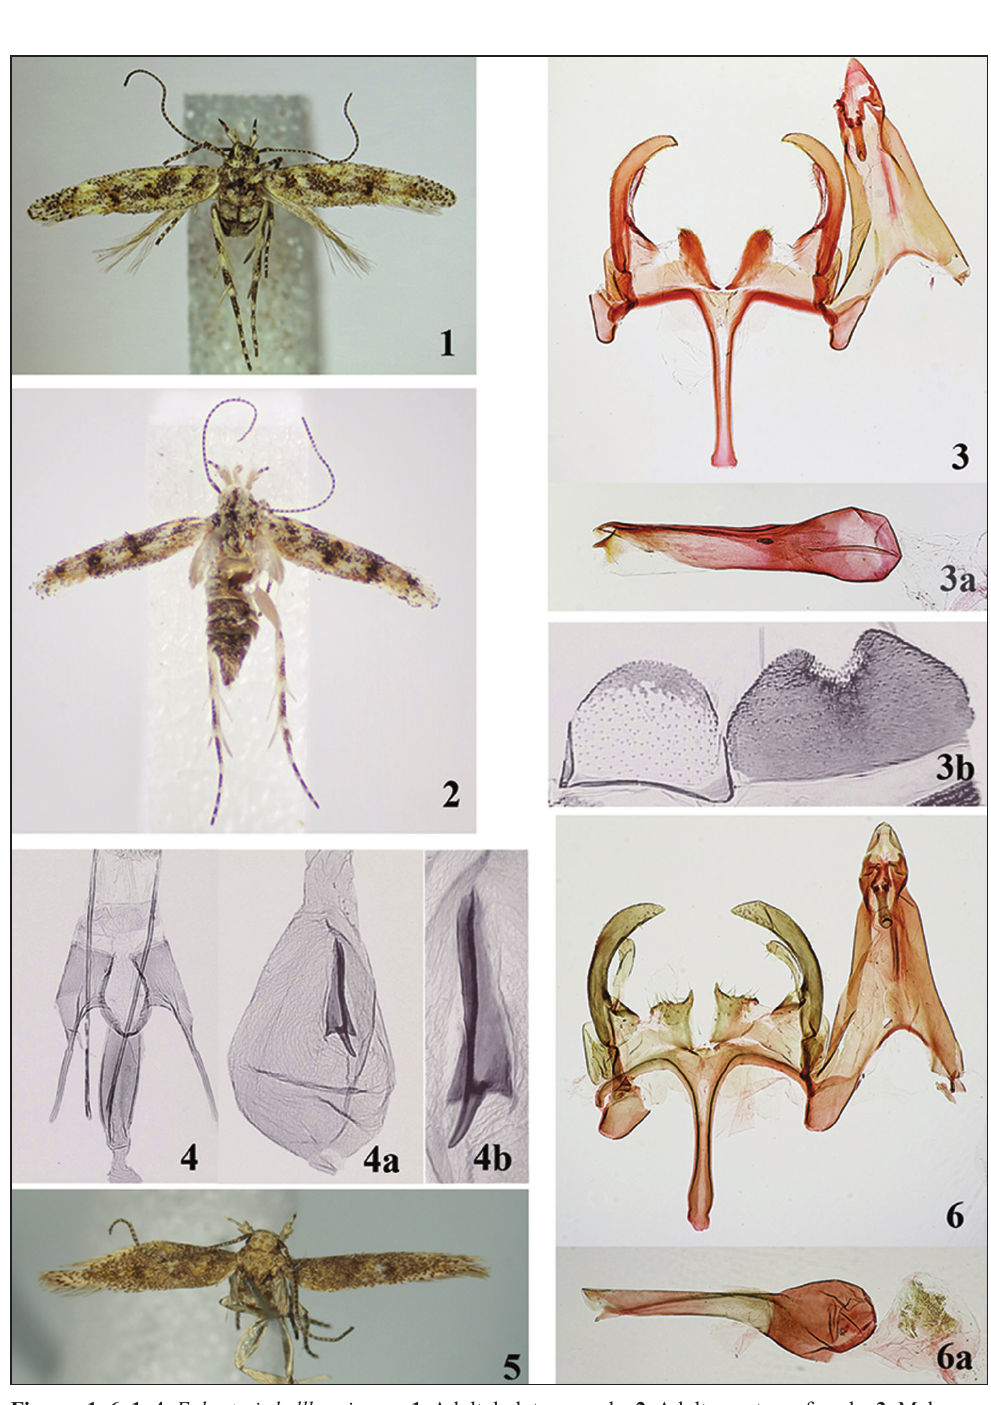
Figures 1–6. 1–4. Ephysteris kullbergi sp. n. 1. Adult, holotype, male. 2. Adult, paratype, female. 3. Male gen - italia, holotype (gen. slide 153/16, O. Bidzilya). 3a. Phallus. 3b. Abdominal segment VIII (gen. slide 4873, O. Karsholt). 4. Female genitalia (gen. slide 4874, O. Karsholt). 4a. Corpus bursae. 4b. Signum enlarged. 5, 6. Eph- ysteris ustjuzhanini sp. n. 5. Adult, holotype, male. 6. Male genitalia (gen. slide 210/14, O. Bidzilya). 6a.